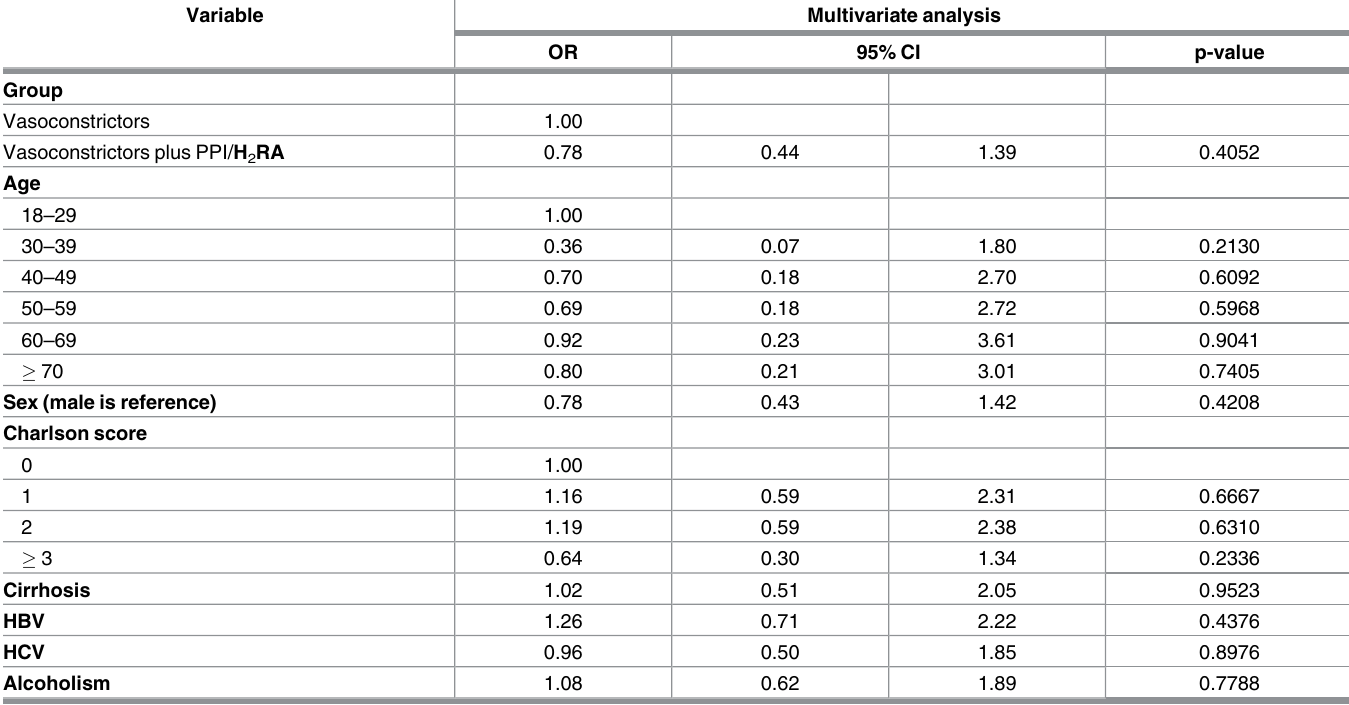
Table 3. Independent risk factors of rebleeding in all study populations during the index hospitalization.